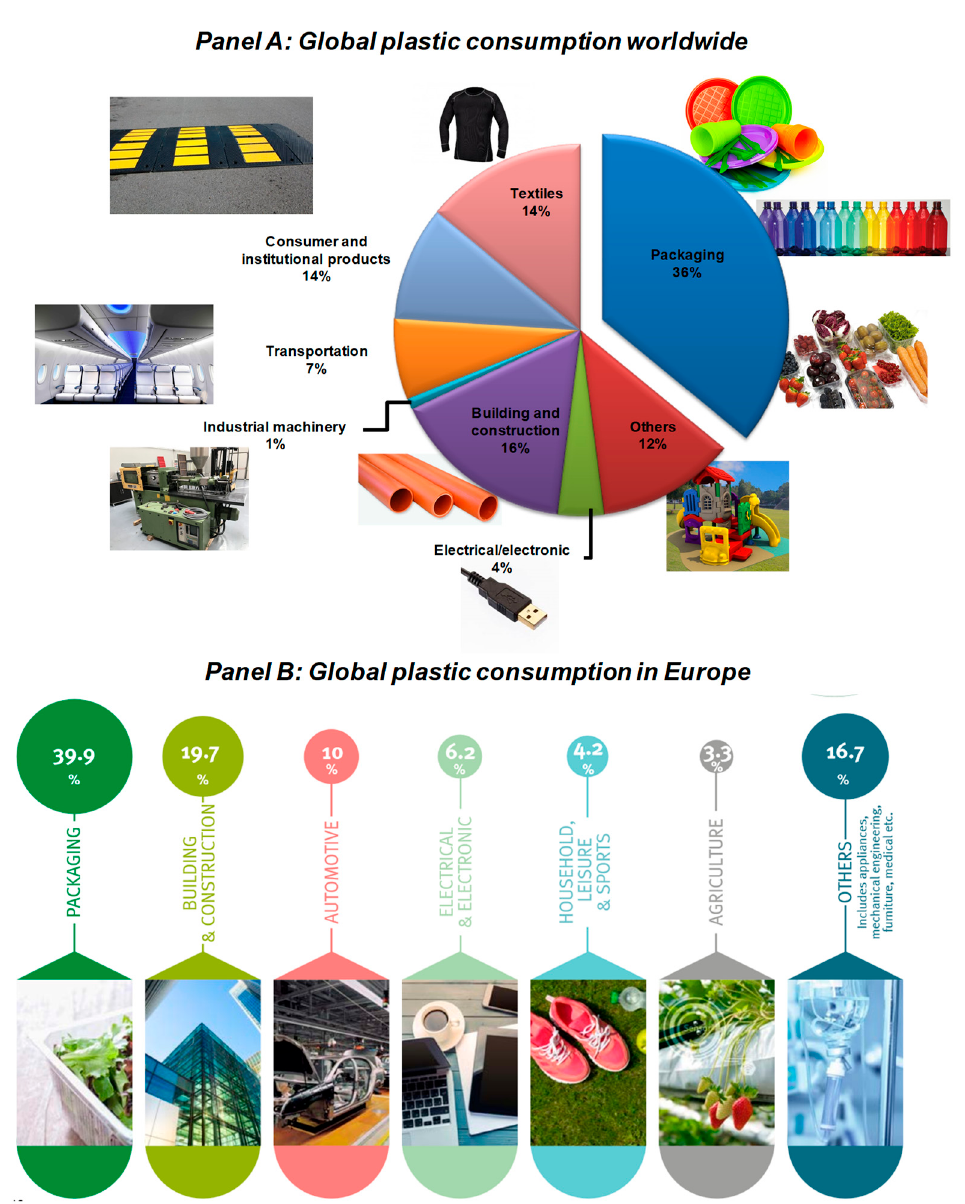
Figure 2. Panel A : Global worldwide plastic production and related application sectors; Panel B : Global plastic consumption in Europe [101].